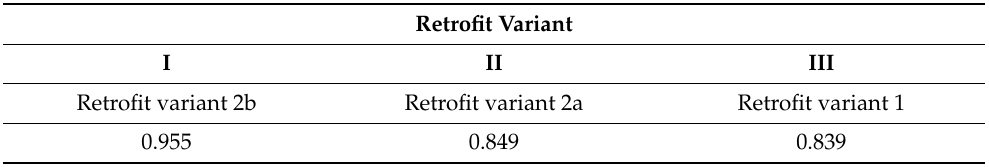
Table 7. Ranking of the retrofit variants according to the MCDM